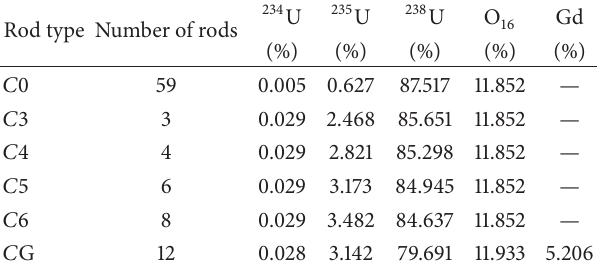
Table 2: Isotopic composition of fuel bars for blue assembly in Figure 1.UO 2 andUO 2 -Gd 2 O 3 barswithoverallaverageenrichment of 1.76% of 235 U (relative to total U). Fuel rods with Gd admixture have enrichment of 5.2% (in total) and 3.792% (relative to U).